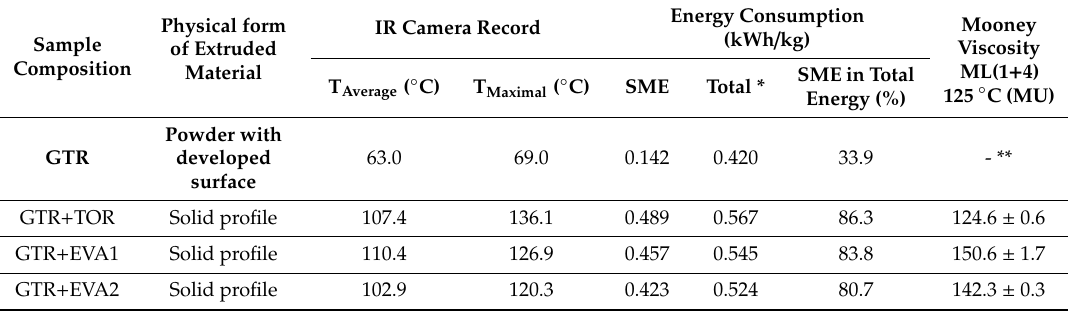
Figure 2. IR camera images of: GTR ( A1 , A2 ) and GTR+EVA2 ( B1 , B2 ). Table 4. Temperature and energy consumption measurements as function of sample